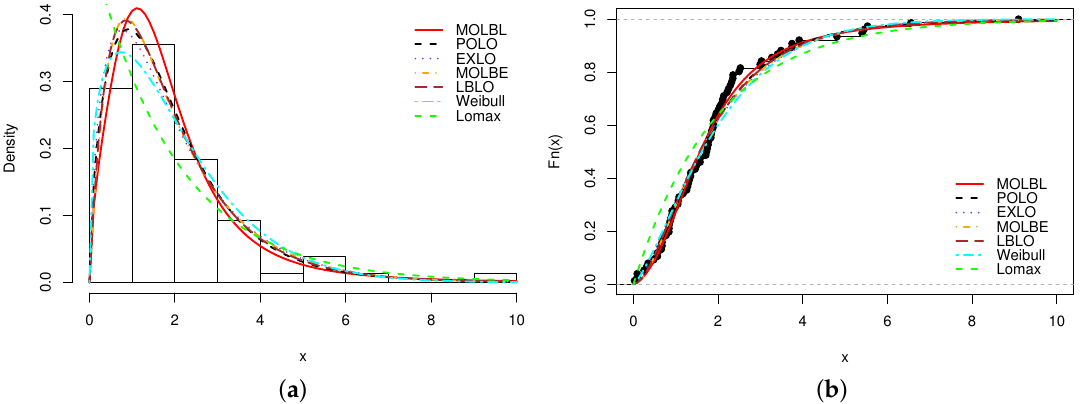
Figure 2. Plots of ( a ) estimated pdf and ( b ) estimated cdf of the MOLBL model with those of the other competitive models for Data set